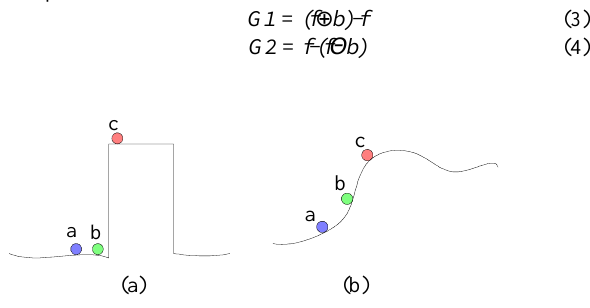
Figure 1. Distribution sketch of LIDAR